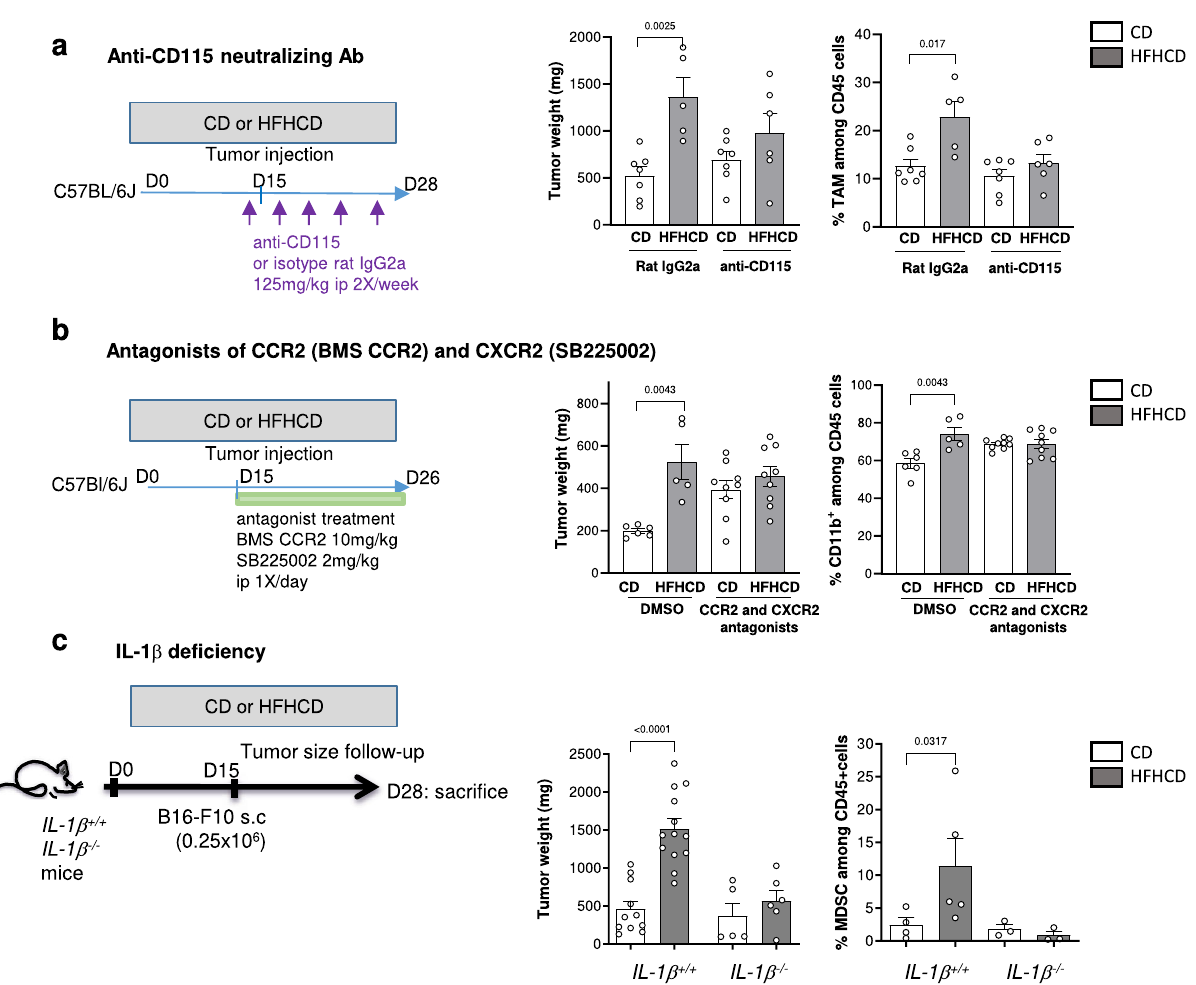
Fig. 4 | Impaired myeloid cell accumulation in the tumor limits tumor growth under HFHCD. C57BL/6J mice, fed with CD or HFHCD and grafted with B16-F10 cells. a Neutralizing anti-CD115 (CSF1R) or isotype (125mg/kg, ip) was injected one day before tumor graft then every 3 days. (left) Experimental design, (middle) tumor weight and (right) fl owcytometryanalysisof TAM in the tumor ( n =14 mice on CD, n =11 mice on HFHCD, among which n =7 and n =6 mice were respectively treatedwithanti-CD115antibody). b CCR2antagonist(BMSCCR2,10mg/kg,ip)and CXCR2 antagonist (SB225002, 2mg/kg) were injected every day from the day of tumor graft. (Left) Experimental design, (middle) Tumor weight and (right) fl ow cytometry analysis of CD11b + myeloid cells in the tumor. ( n =15 mice on CD, n =14